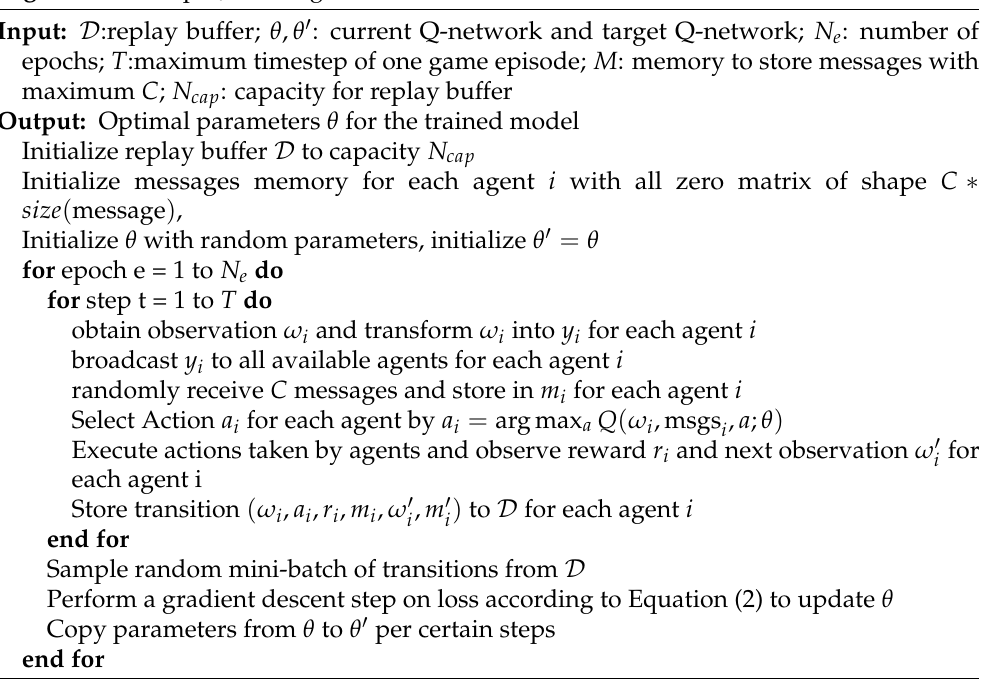
Algorithm 1 Deep Q-learning with ACUTE